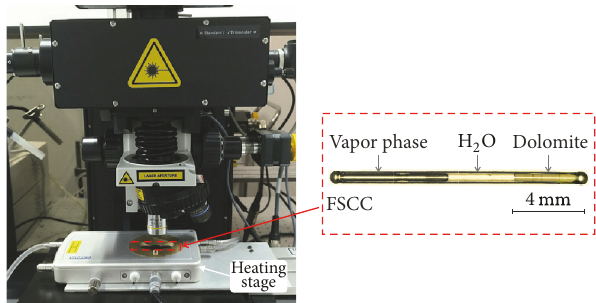
Figure 1: Setup for in situ analyses of the vapor phase within a FSCC containing dolomite and